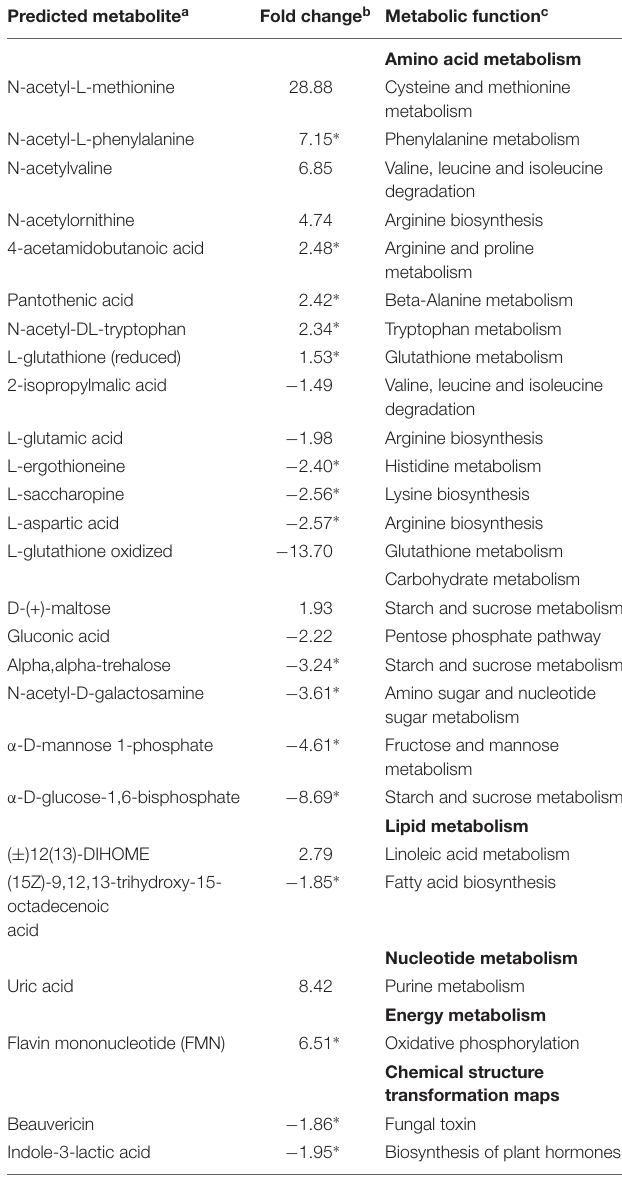
TABLE 2 | Effects of exposure to V. dahliae ELV22 on F. oxysporum FO12 metabolism detected by